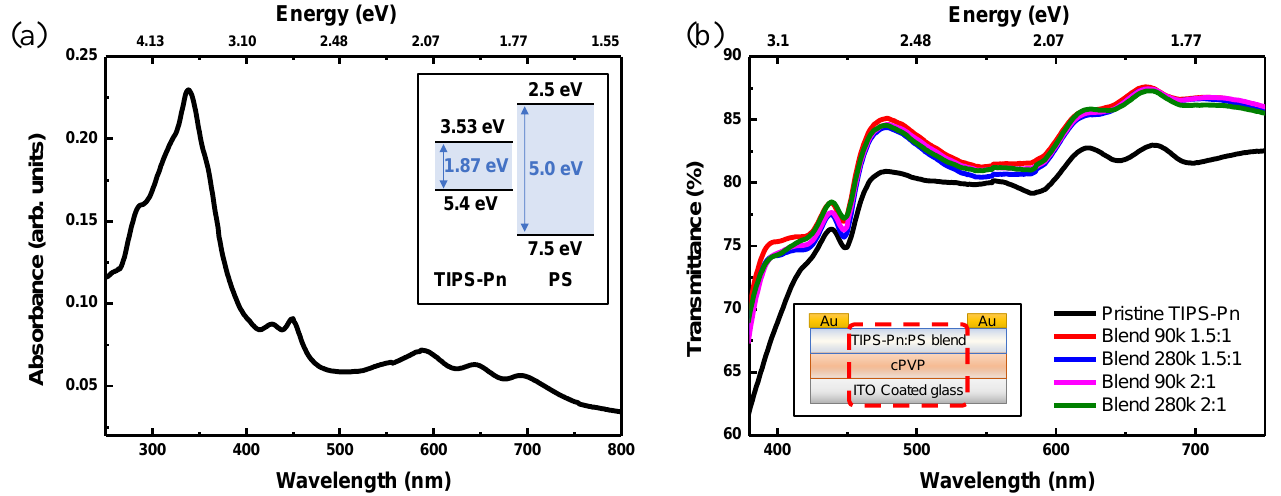
Figure 4. ( a ) UV/visible spectrometer measurements for the TIPS-Pn thin film (inset: energy band diagrams of TIPS-Pn and PS) and ( b ) transmittance in the visible light range (380 – 750 nm) for the pristine TIPS-Pn and four types of blended TIPS-Pn/PS TFTs in the channel region excluding the source/drain electrode (inset: schematic diagram showing the area where the transmittance was measured, indicated by the red dotted line).